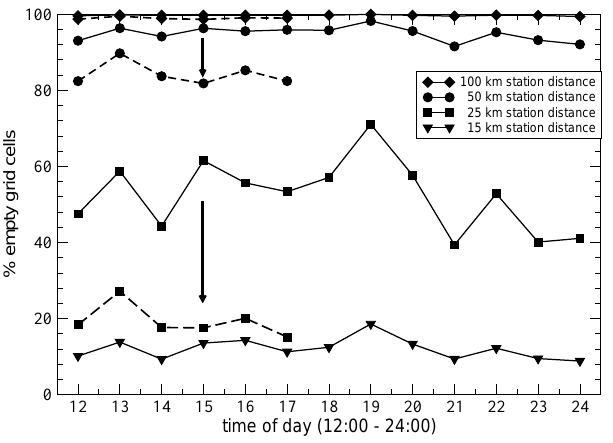
Fig. 6. Distribution of intersection points per gid cell within a 15 × 15 × 0 . 5km grid. All distributions have been normalised to